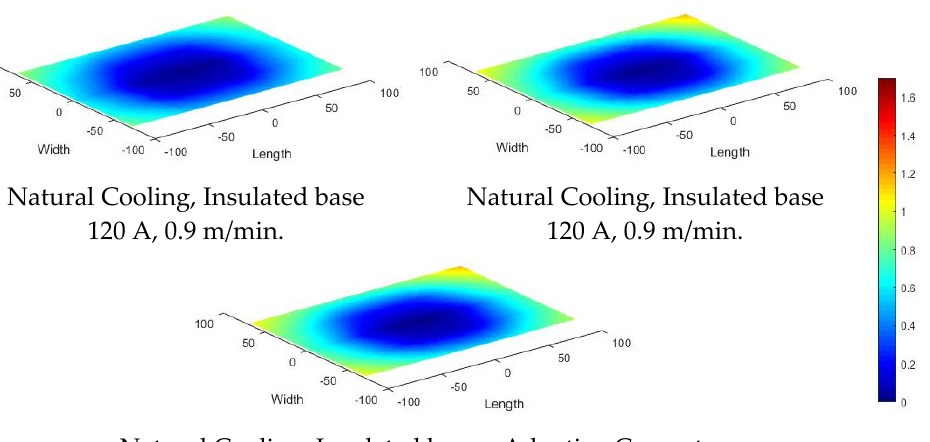
Figure 9. Distortion plots for an active set of experiments.